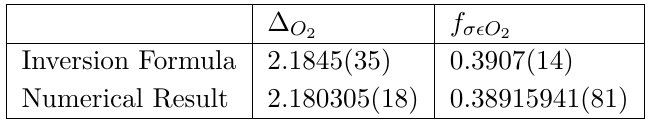
Table 2 . Twist and OPE of spin 2 operator, O 2 in [ σ(cid:15) ] , derived analytically compared with the value derived from numerical